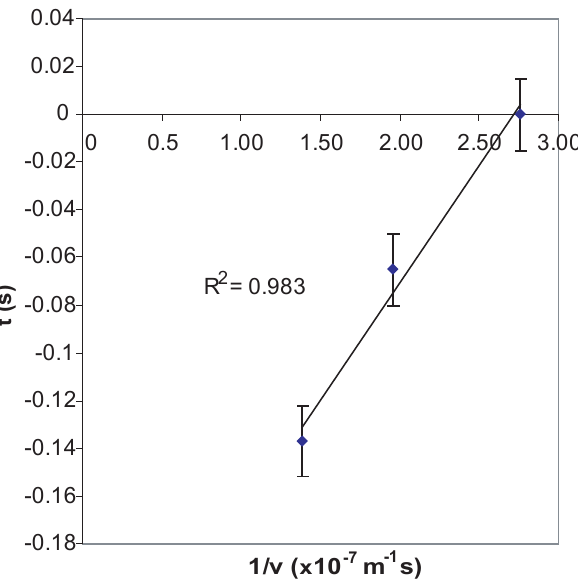
Fig. 7. Reciprocal velocity corresponding to each electron channel against lag time for interval 2 shown in pink on Fig. 3.